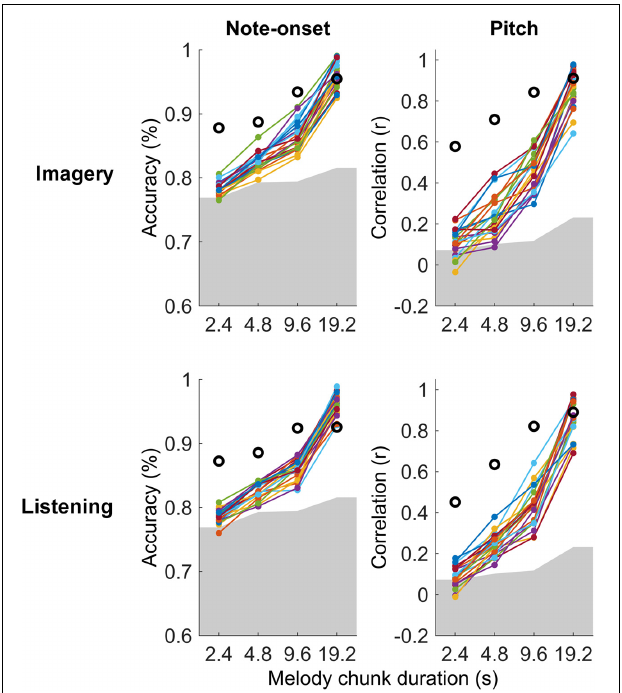
FIGURE 3 | Single-subject melody decoding from EEG. Single-subject melody decoding from EEG (0.1–30 Hz) with maxCorr. Note-onset decoding accuracies (left) and pitch decoding correlations (right) are reported for the imagery and listening conditions. Grey shaded areas indicate the chance level (95th percentile of a distribution obtained by shuffling 100 times the identification indices of the EEG segments for each subject). Black circles indicate the decoding for the virtual best subject obtained by extracting EEG signal components that are most consistent across all participants with MCCA. Supplementary Figure 2 shows the results of this analysis for EEG filtered in the frequency band 1–30 Hz.